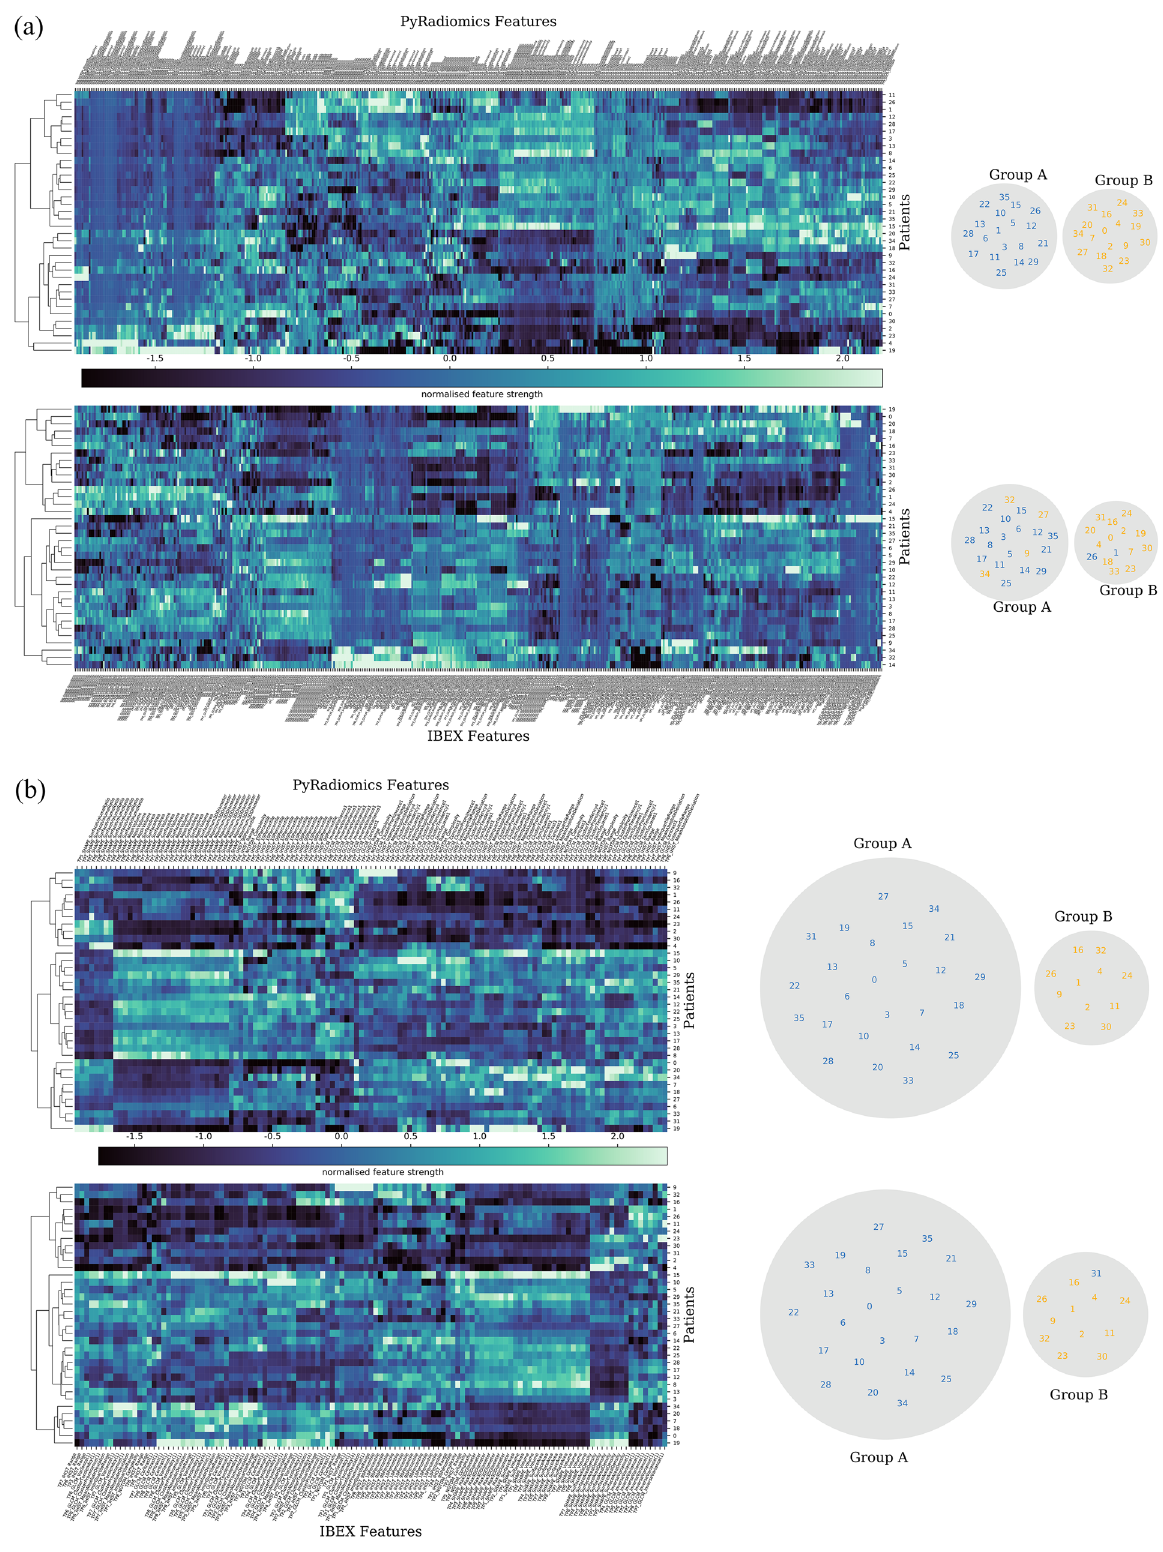
Figure 3. Summary of linear correlation of apparent diffusion coefficient (ADC) radiomic features between PyRadiomics and (white) MaZda and (purple) IBEX software. The reproducibility threshold (red-dashed line) is defined as greater than a Pearson correlation coefficient of 0.901. This analysis identified a sub- set of reproducible features between IBEX and PyRadiomics from intensity histogram (5/7), shape (4/6), GLCM (neighbourhood 1:4/18, 4:1/18, 7:0/18), GLRLM (0/11) and NGTDM (1/5) categories. The sub-set of reproducible features between MaZda and PyRadiomics is intensity histogram (5/6), shape (2/6), GLCM (neighbourhood 1:3/10, 3:4/10, 7:2/10), GLRLM